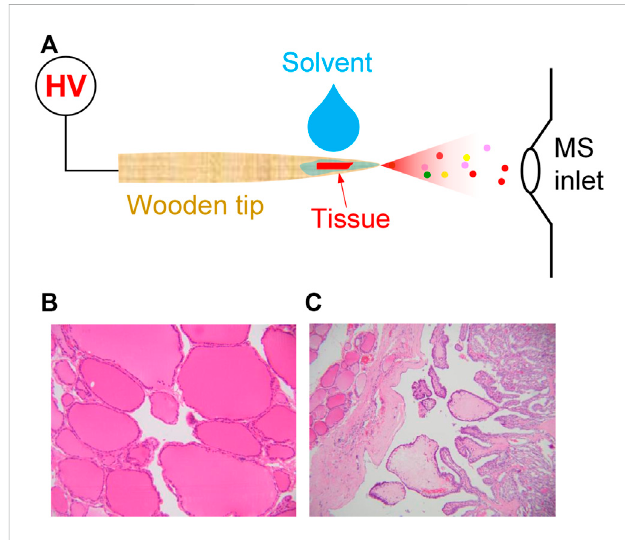
FIGURE 1 (A) WT-ESI-MS analysis of tissue sample; (B) normal thyroid tissue, (C) thyroid cancer tissue, irregular papillary structure, covered with a layer of neoplastic follicular epithelium with characteristic nuclear